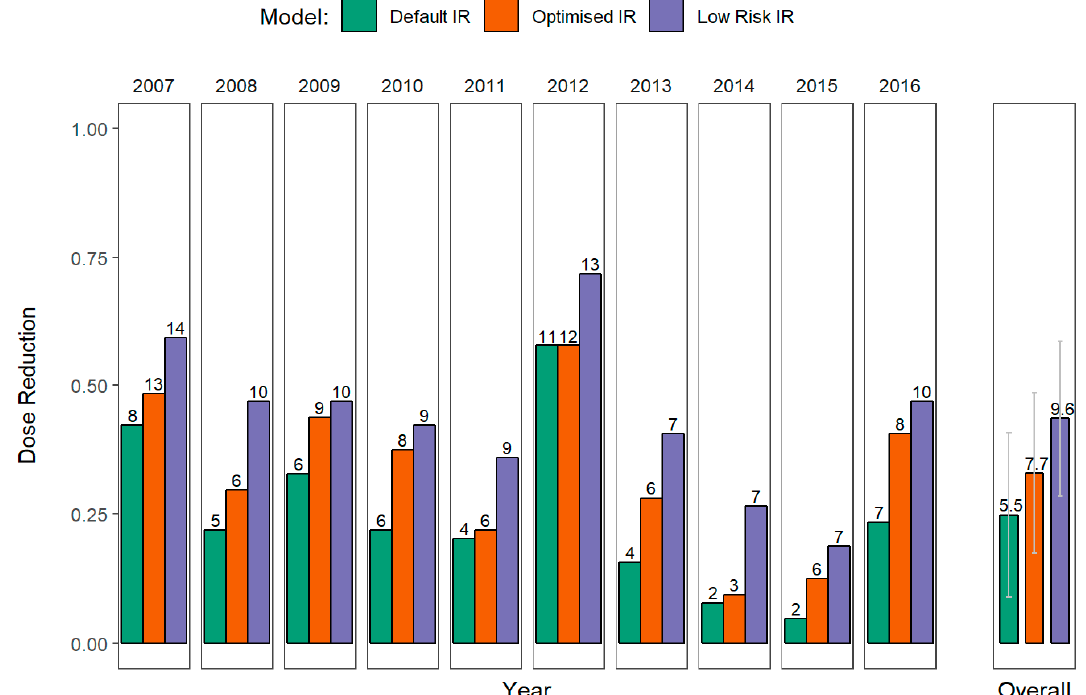
Figure 8. Dose reduction and number of treatments recommended per year by the IR: optimized model and low risk model. Facets marked with the year on top represent summaries for individual years while the last facet represents the averages and variance across all years. In the facets for the individual years, the height of bars represents the proportion of the dose applied per model compared to the total dose, while numbers at the top of the bars represent the total number of treatments recommended by the model in each year. In the overall summary (facet on the far right), height of the bar represents the mean dose reduction, the number above the bar is the mean number of treatments during the year and the error bar represents standard deviation.